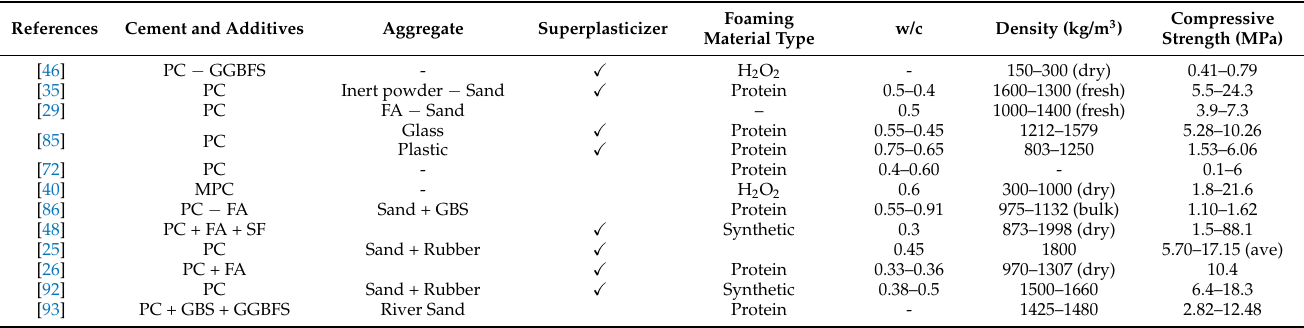
Table 8. Compressive strength values for different